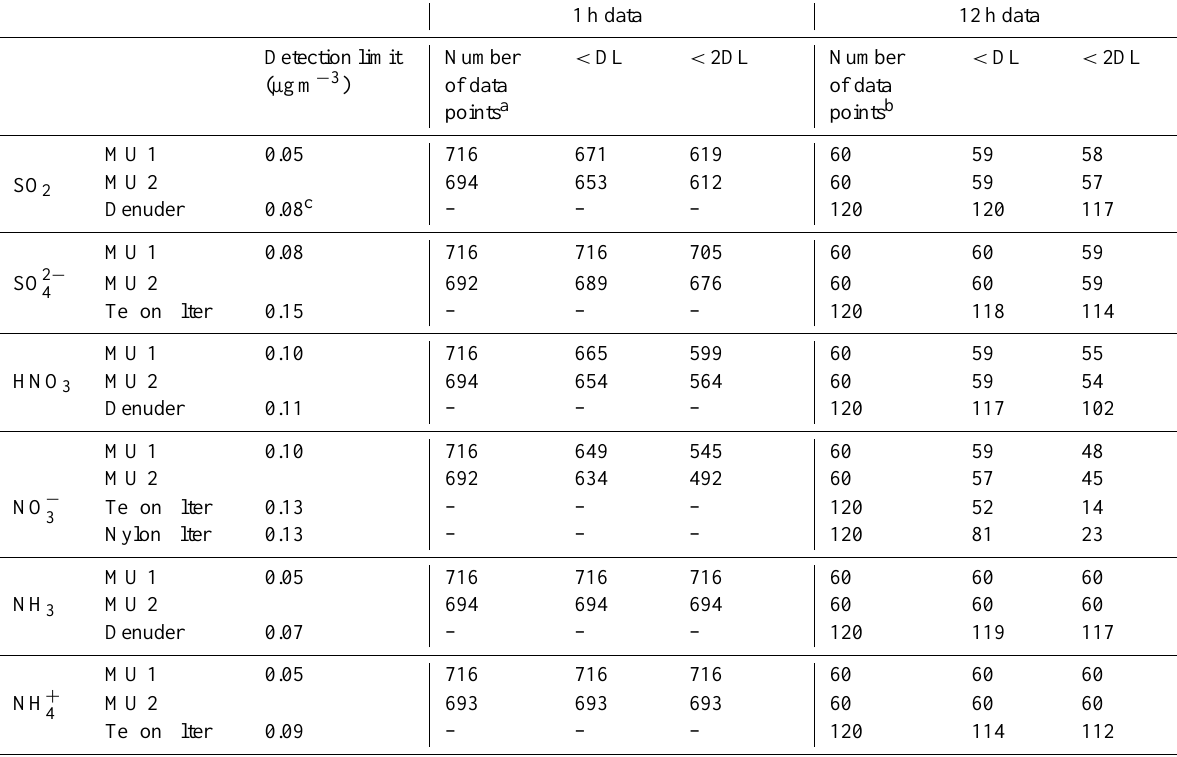
Table 1. Summary of data collection and detection limits for each compound and for each measurement